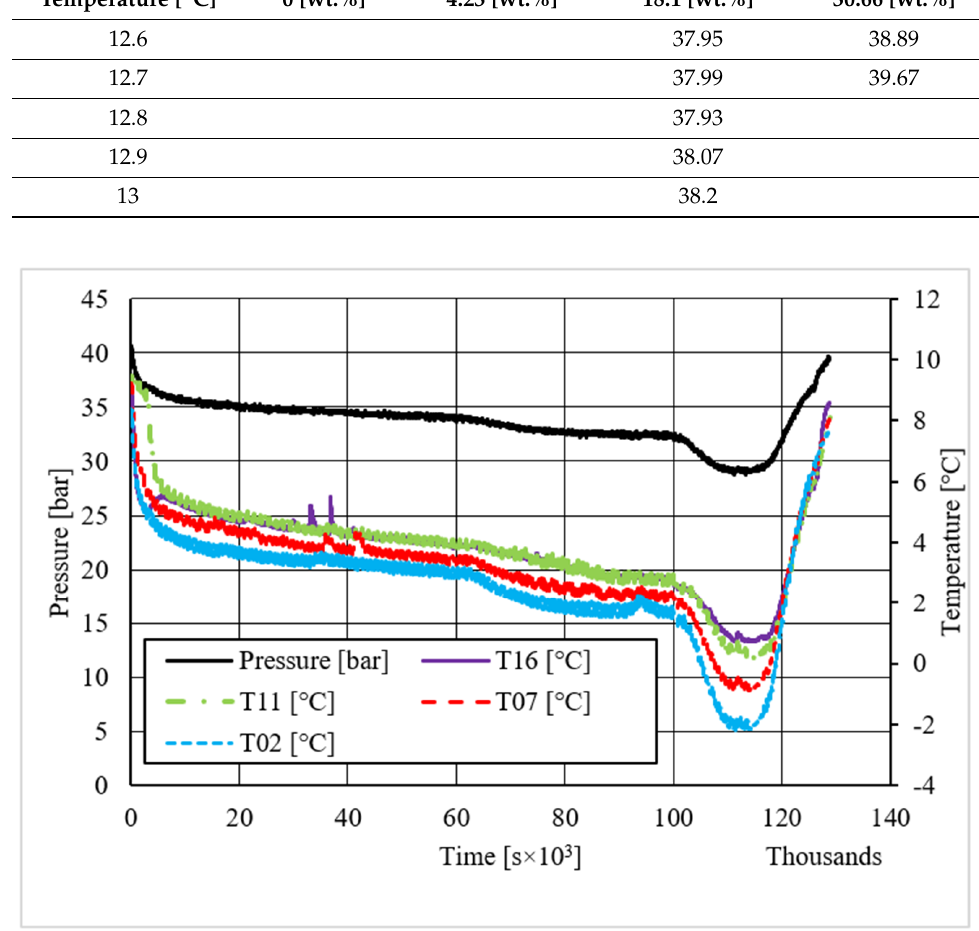
Figure 14. Pressure and temperature trends over time, measured for carbon dioxide hydrate formation in the absence of CuSn12 powder.